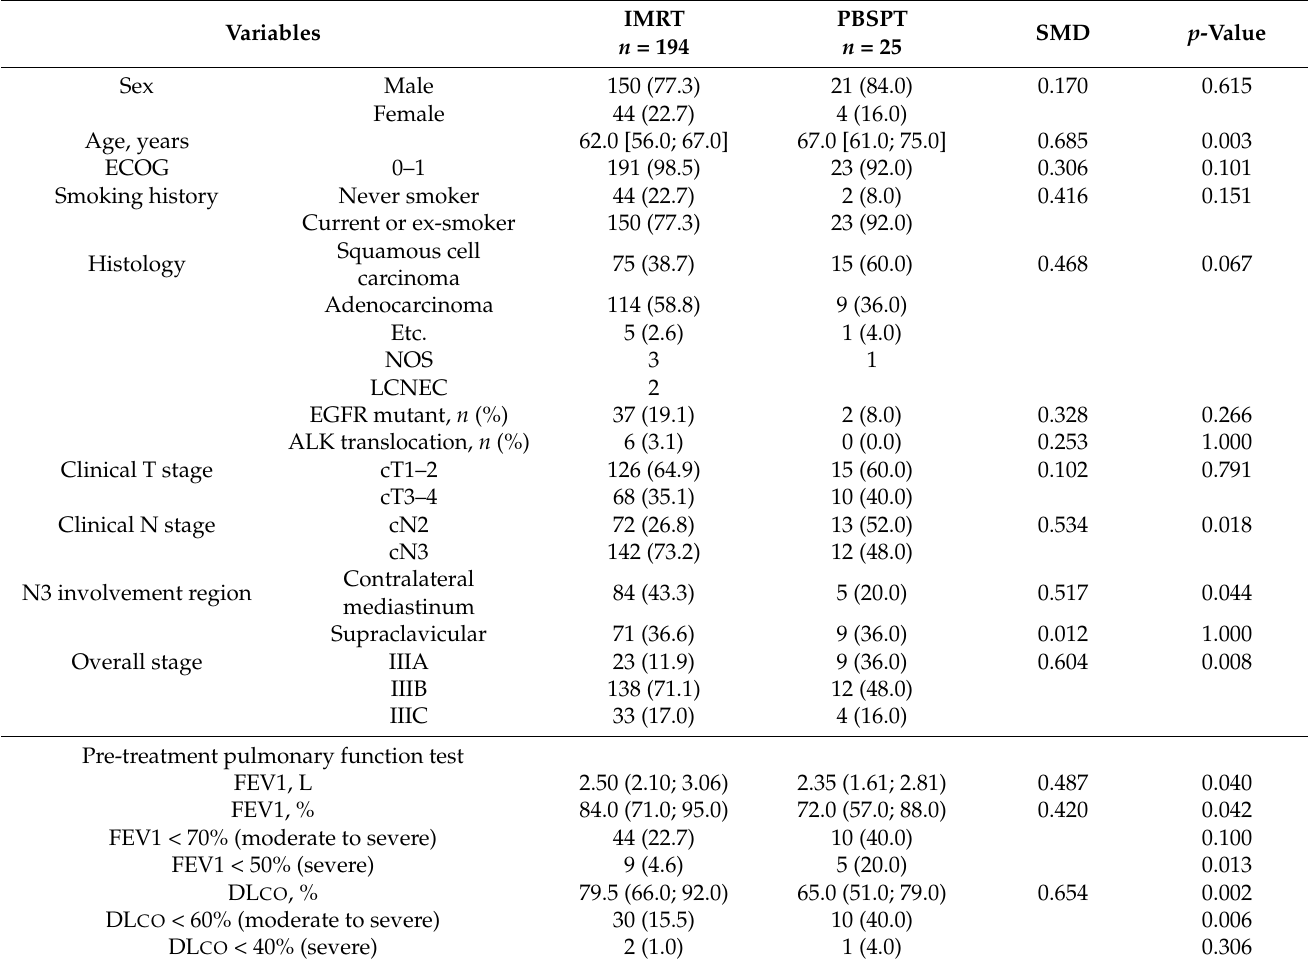
Table 1. Patient, tumor, and treatment